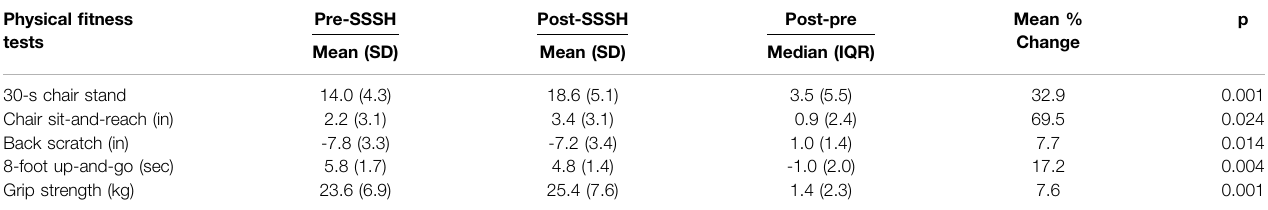
TABLE 1 | Results of functional tests before and after the 8-week exercise program Stay Strong Stay Healthy (SSSH). Percent change shown as absolute number. Physical fi tness